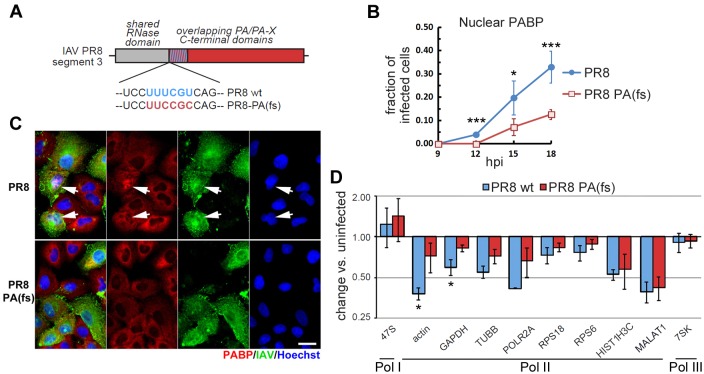
PA-X selectively degrades Pol II transcripts in infected cells.(A) Schematic representation of the PA gene of IAV showing the sequence of the frameshift site in the wild-type PR8 and the substitutions made to generate PR8-PA(fs) mutant virus. (B-D) A549 cells were infected with PR8 or PR8-PA(fs) at a multiplicity of infection (MOI) of 1. The fraction of infected cells displaying nuclear PABP was quantified (B) by immunofluorescence staining (C) of cells fixed at the indicated time points. A minimum of 200 cells were quantified in each sample. (D) Total RNA was harvested at 12 hours post-infection (hpi) and RT-qPCR was performed to measure levels of the indicated endogenous RNAs. Endogenous RNA levels were normalized to 18S rRNA levels and plotted as fold change in infected vs. uninfected cells. Error bars = st. dev. from three independent biological replicates. *,*** = p value < 0.05, 0.005 for PR8-PA(fs)- vs. PR8-infected cells.